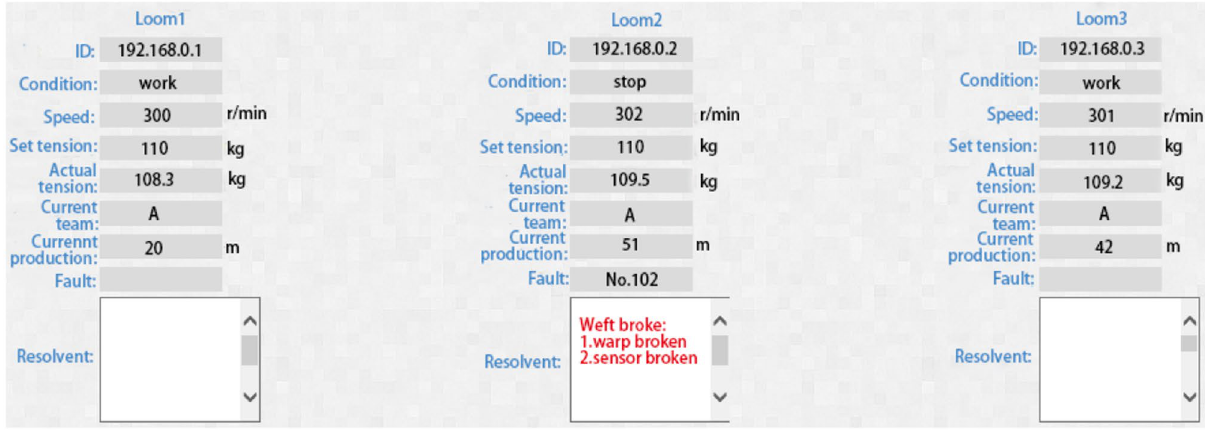
Fig. 26 Remote system multi-machine management